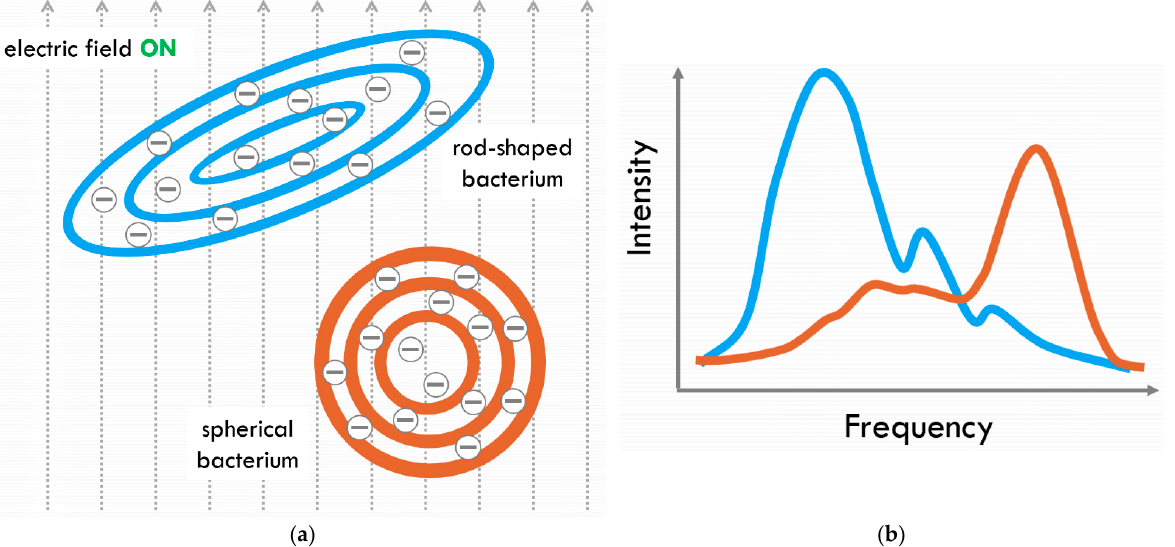
Figure 1. The schematic representation of the principle behind Fluid-Screen DEP technique. ( a ) Electric field induces a dipole in every building block of a bacterium (we call a sum of all of these dipoles “super dipole”). The super dipole depends on shape, size, morphology and chemistry of the particle; Biological particles suspended in the liquid sample are captured and concentrated on the basis of super dipole interacting with an electric field. Such interaction leads to very fast, efficient, and reliable capture and separation of a variety of microbial cells from other particles (particle size is not a key factor, thus FS can concentrate across sizes). ( b ) Fluid-Screen DEP response spectrum (schematic represention) is different for each bacterial species due to differences in shape, size, morphology and chemistry of the particle; this effect allows for selective capture and separation of microorganisms.